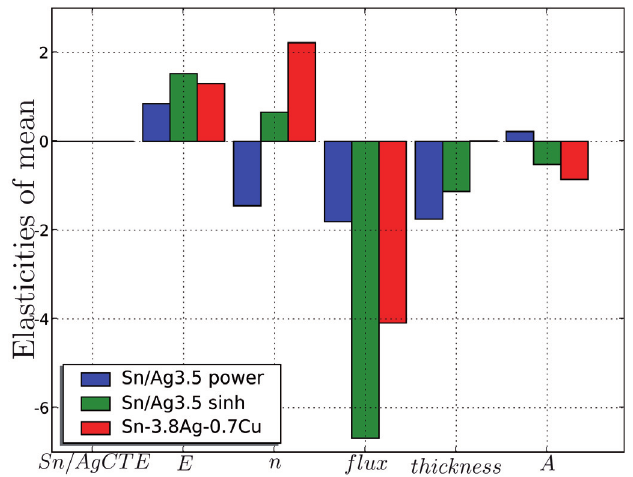
Fig. 7. Elasticities of the random variable’s mean for different solder alloys.